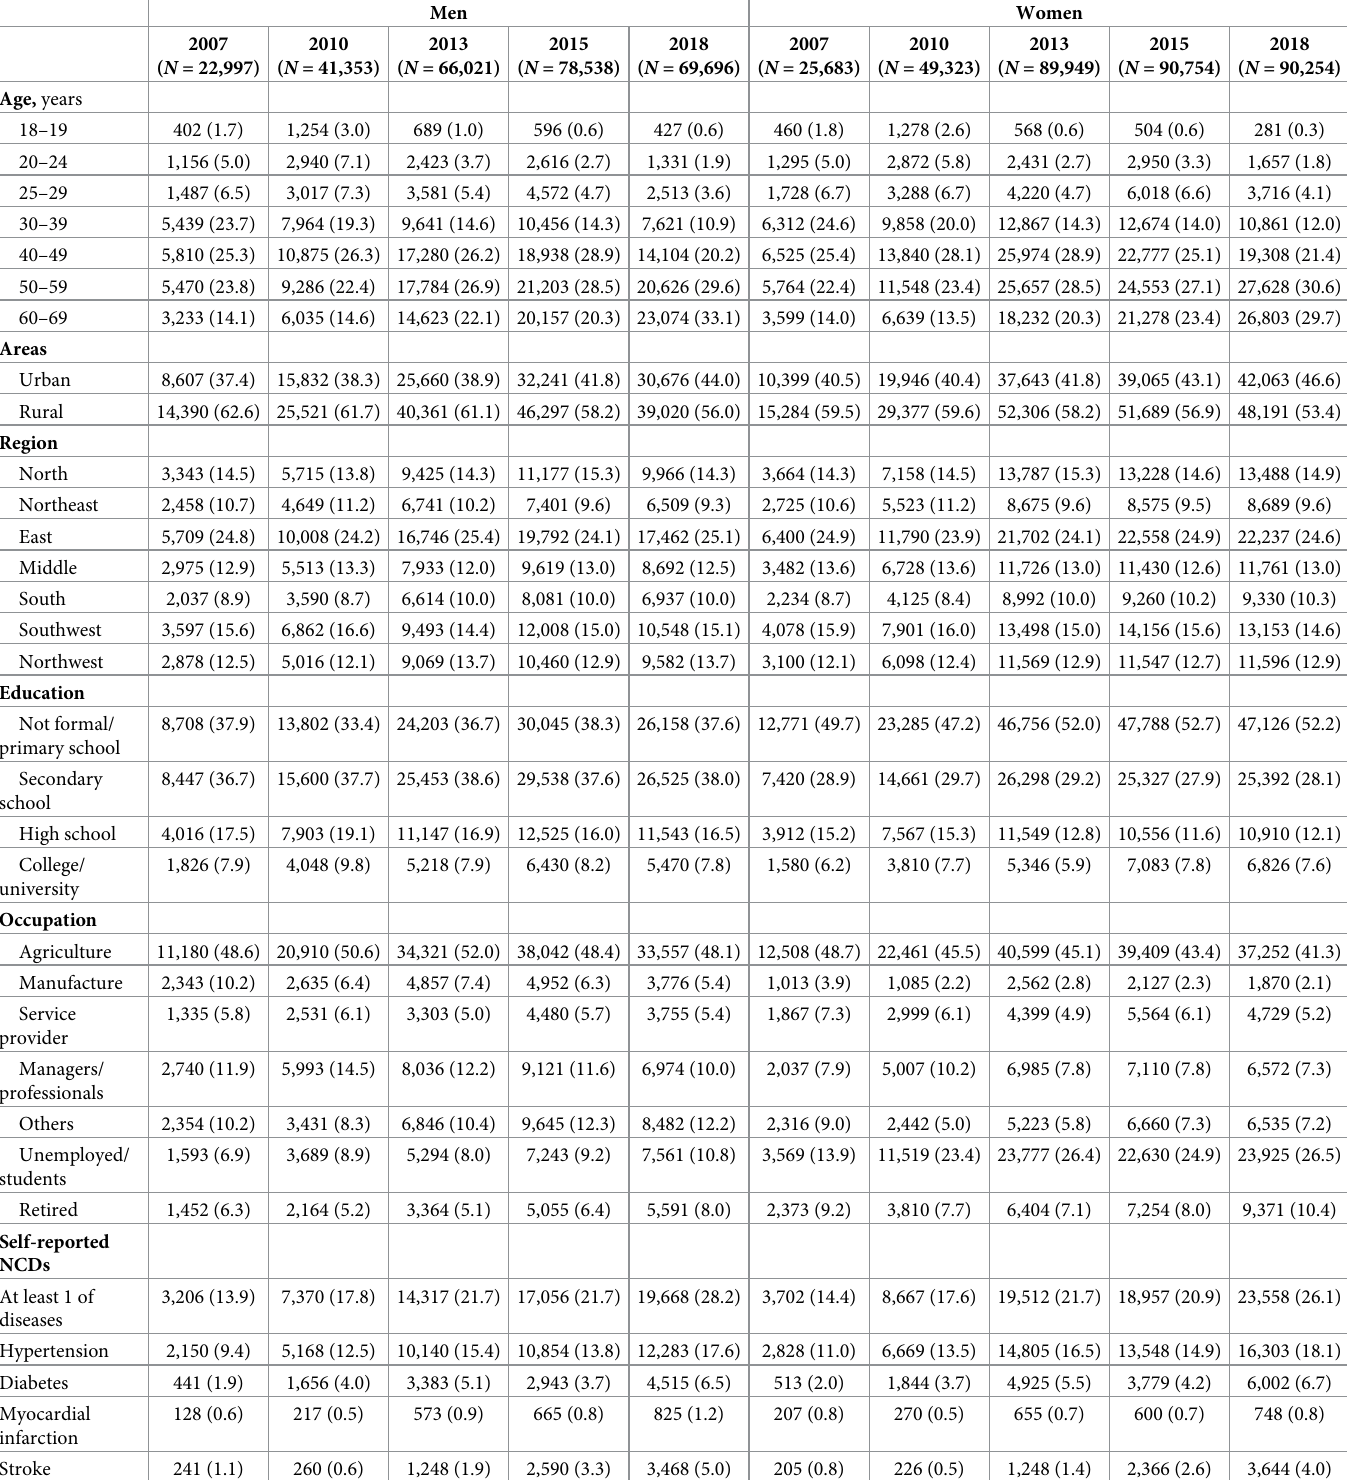
Table 1. The characteristics of participants enrolled in the 5 CCDRFS surveys during 2007–2018. Values are numbers (percentages).